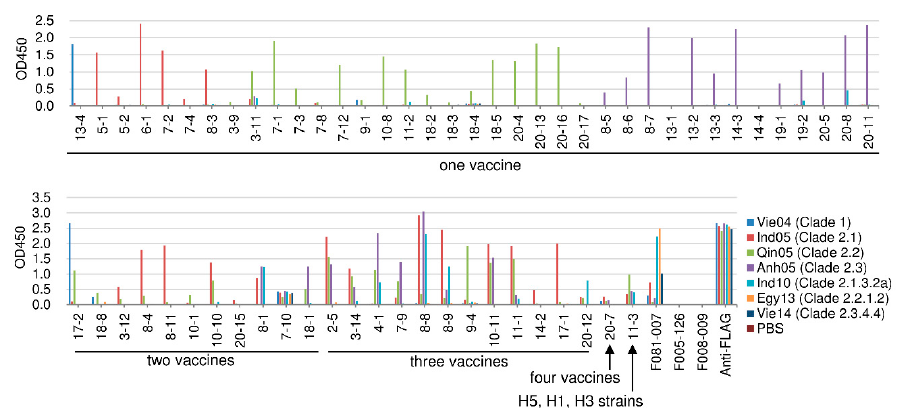
Figure 3. Binding activity of HI-positive clones to recombinant HA molecules derived from seven kinds of H5N1 viruses. Binding was measured by ELISA. F081-007 is an anti-H1 and -H5 HA antibody that was used as a positive control. F005-126 (an anti-H3 HA antibody) and F008-009 (an anti-influenza nucleoprotein antibody) were used as negative controls. Anti-FLAG antibody was used for detecting the FLAG tag that had been fused to the recombinant HA. The binding activity is shown as the optical density at 450 nm (OD450).